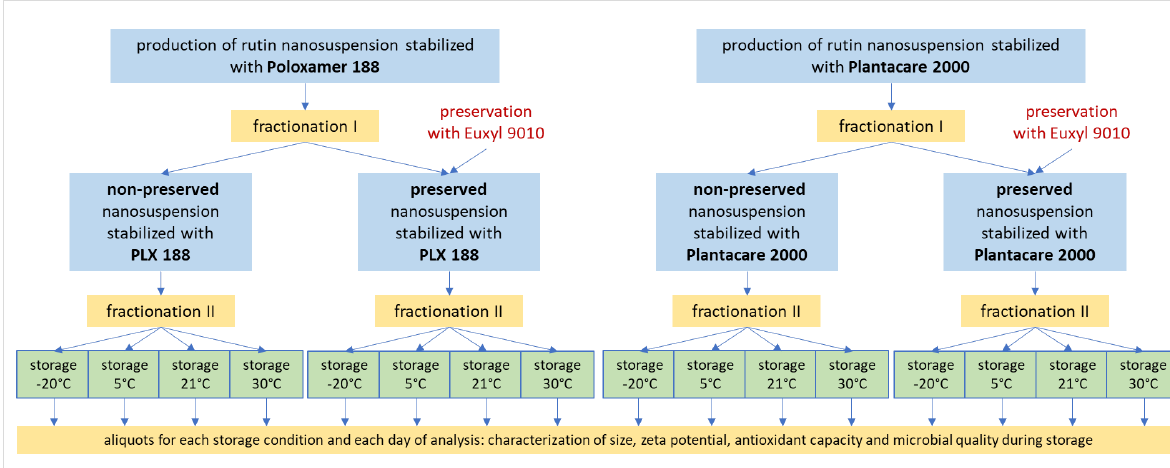
Figure 1: Scheme of the study. Rutin nanosuspensions with two different stabilizers were produced. The formulations were allocated, one aliquot was preserved, and the other part remained non-preserved. All formulations obtained were stored at different temperatures for three months. During this time changes in size, zeta potential, antioxidant capacity and microbial quality were monitored.